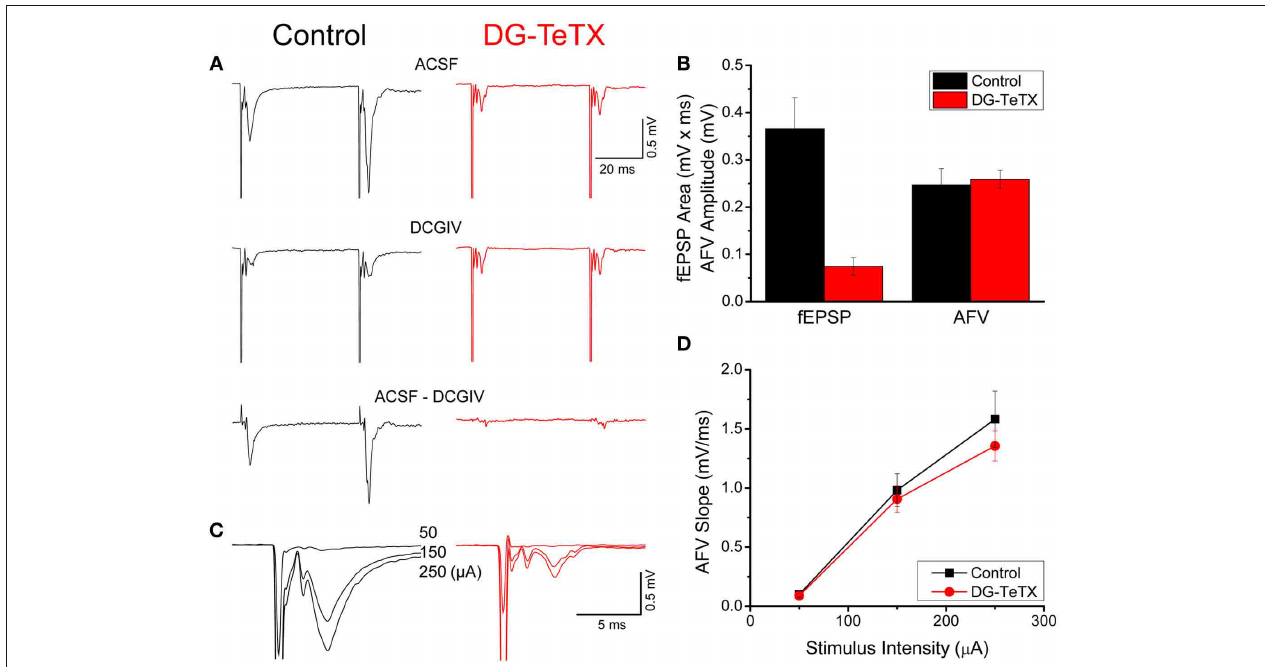
FIGURE 1 | Impaired MF-CA3 transmission but normal MF excitability in activated DG-TeTX mice. (A) Representative fEPSP waveforms recorded in CA3 stratum lucidum evoked by stimulation in the DG GC layer obtained in control and activated DG-TeTX (DG-TeTX) mice in control (ACSF, upper traces) and DCGIV (1 μ M) containing ACSF (DCGIV, middle traces). Traces are the average of 6 consecutive individual sweeps obtained in each condition (scale bars 20ms/0.5mV). The pure MF-CA3-mediated fEPSP is obtained by digital subtraction of the DCGIV condition waveform from the control condition